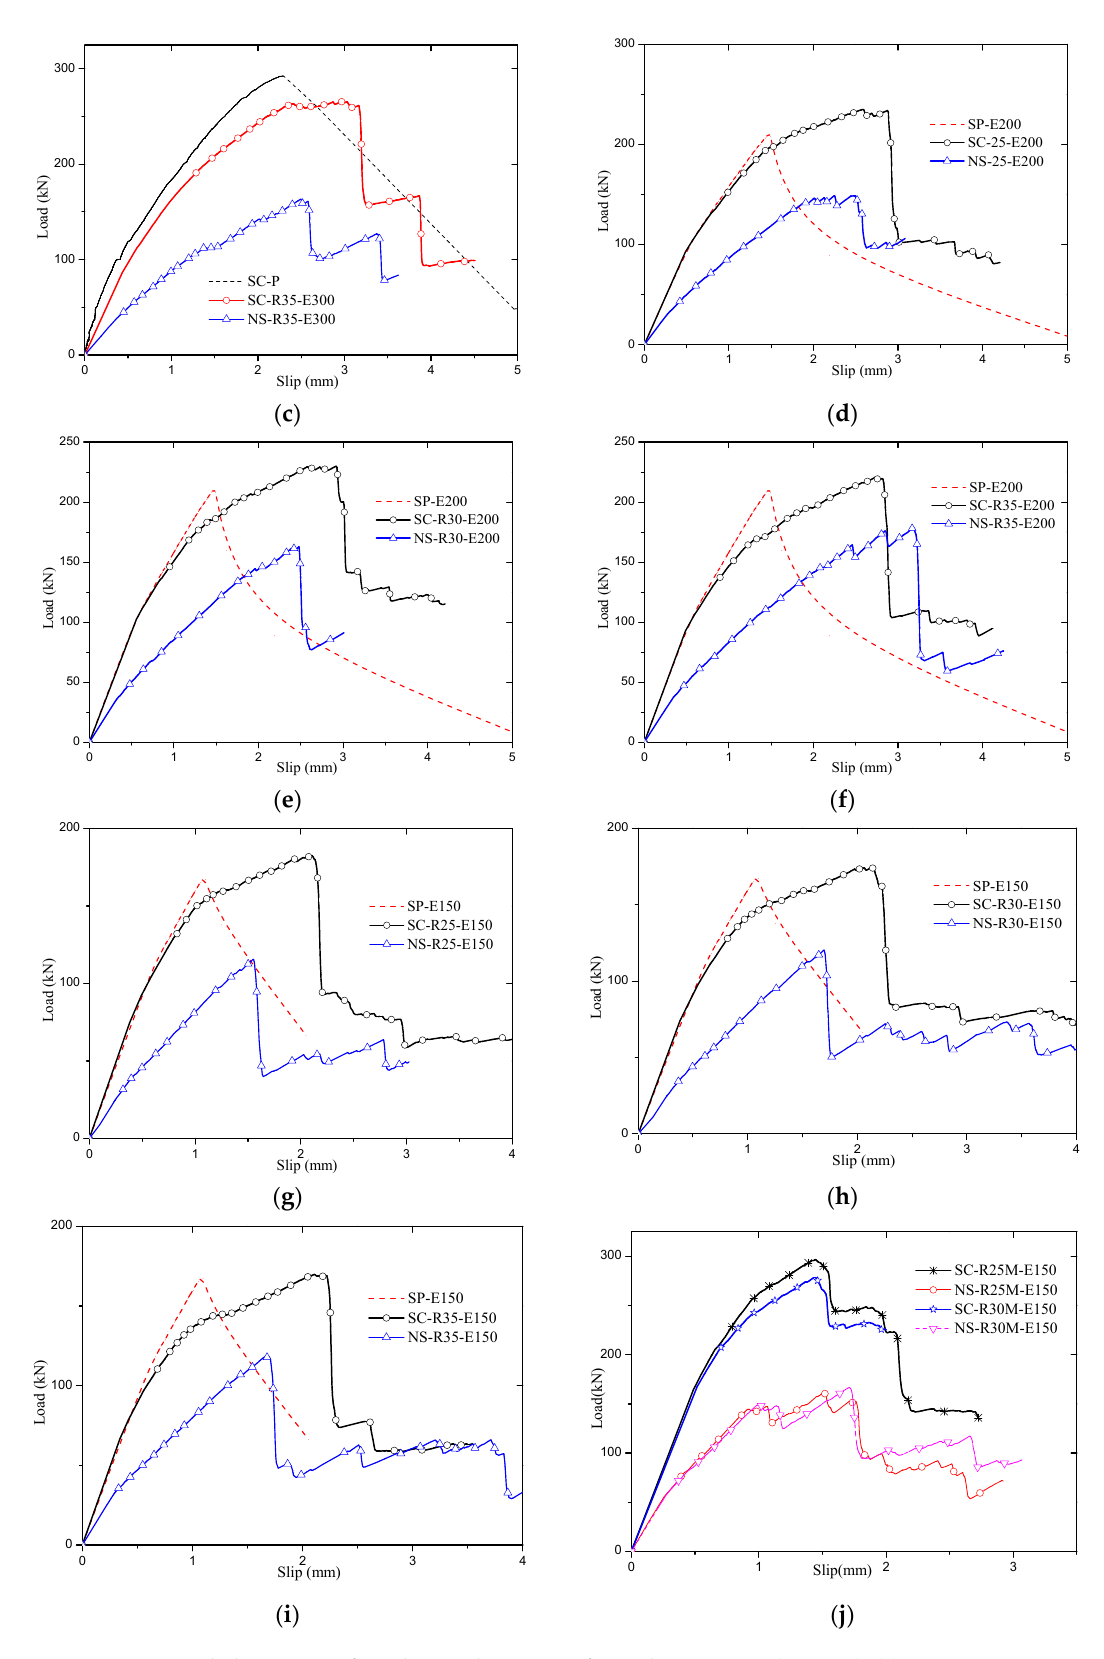
Figure 13. Load-slip curves of sand-coated GFRP perforated connectors (SCGPC). ( a ) R = 25, E = 300; ( b ) R = 30, E = 300; ( c ) R = 35, E = 300; ( d ) R = 25, E = 200; (e) R = 30, E = 200; ( f ) R = 35, E = 200; ( g ) R = 25, E = 150; ( h ) R = 30, E = 150; ( i ) R = 35, E = 150; ( j ) Multi hole.